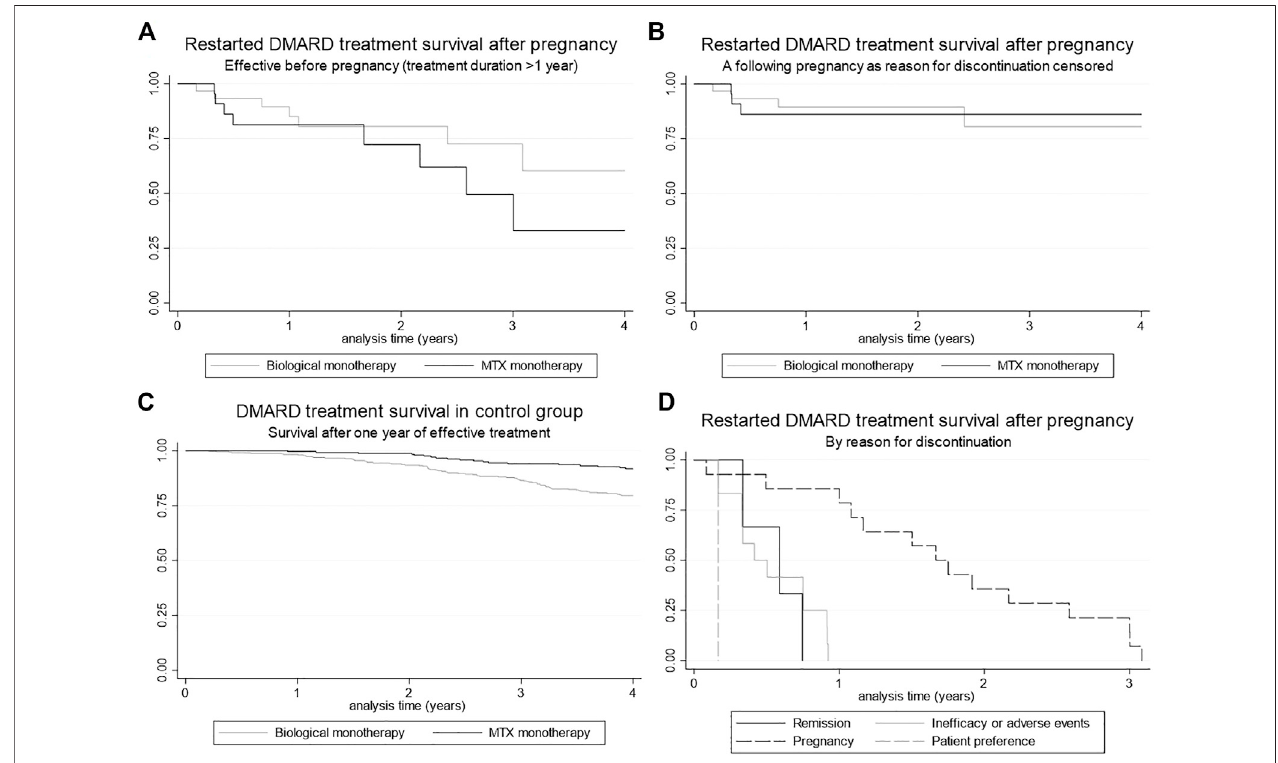
FIGURE 2 | Kaplan Meier curves for DMARD survival (A) Restarted DMARD treatment (biological and MTX) survival after pregnancy, (B) Restarted DMARD treatment(biologicalandMTX)survivalafterpregnancy,censoredforpregnancyasreasonfordiscontinuation, (C) DMARDtreatment(biologicalandMTX)survivalwithin the control group after 1 year of continuous treatment, (D) Restarted DMARD treatment survival after pregnancy, strati fi ed for reason of discontinuation.